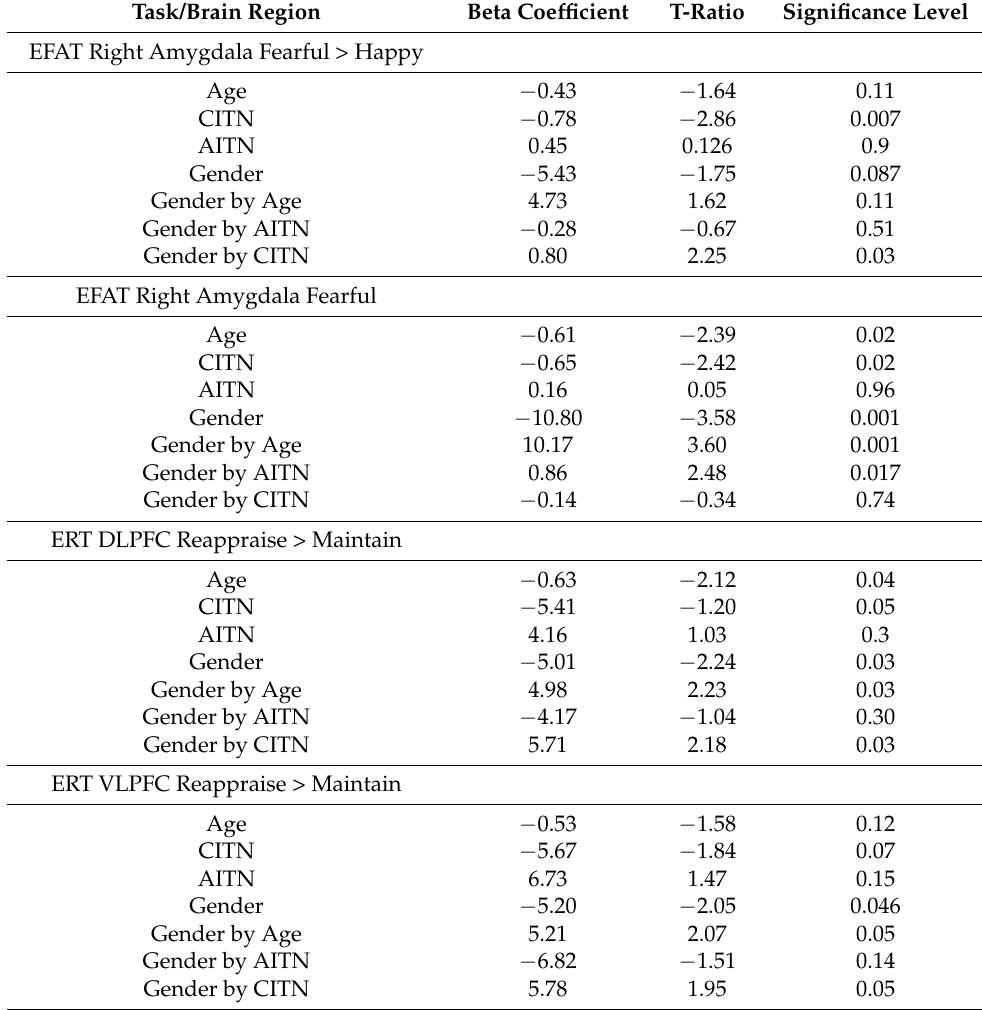
Table 2. Results of regression analysis: only results with significant gender, or gender by childhood income-to-need ratio effects are presented. EFAT = Emotional Face Assessment Task, ERT: Emotion Regulation Task, SEAT: Shifted-Attention Emotion Appraisal Task, CITN: childhood income-to-need ratio, AITN: current adult income-to-need